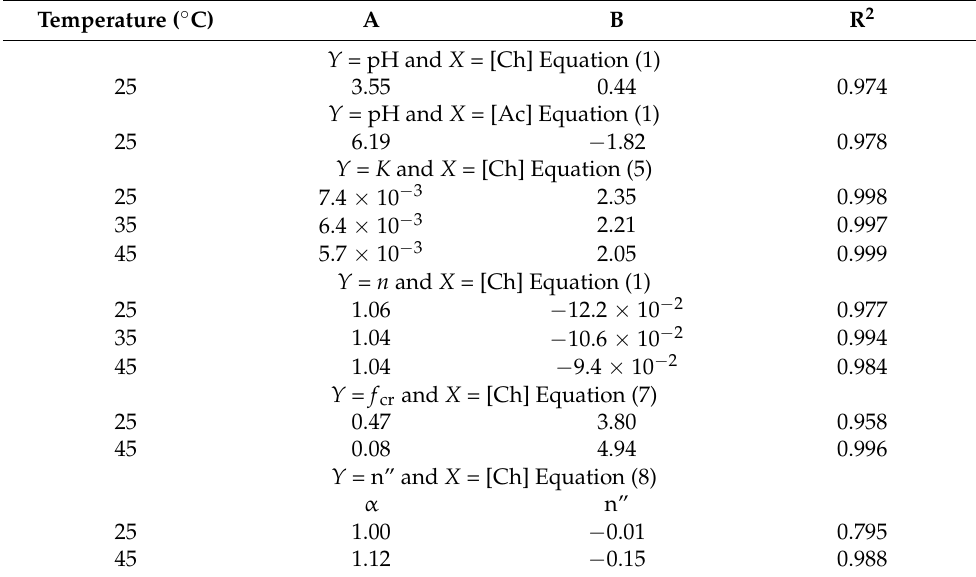
Table 2. Parameters calculated by fitting Equations (1), (5), (7) and (8) to data: Ch and Ac are chitosan and acetic acid concentrations, respectively; K is the consistency index; n is the flow behavior; f cr is the critical frequency; and n” is the relaxation